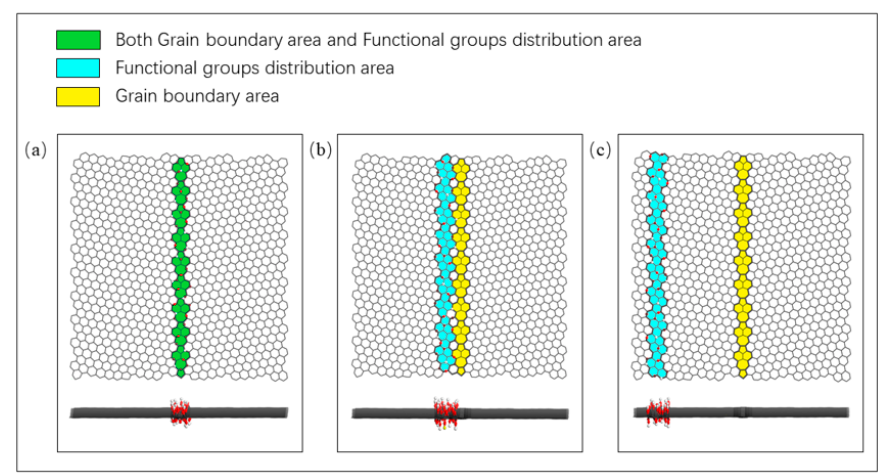
Figure 3. ( a ) The model in which the functional groups are distributed on GBs; ( b ) the model in which the functional groups are distributed beside GBs; ( c ) the model in which the functional groups are distributed away from GBs.